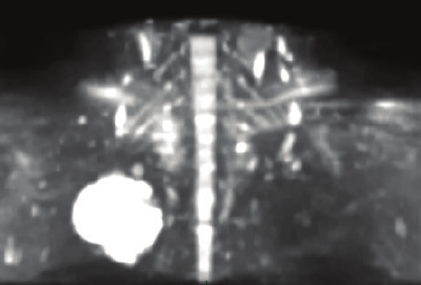
Figure 8: MIP reformatted DW image on the coronal plane which shows the integrity of the brachial plexus. DW imaging makes the radiologist able to selectively identify nervous structures, which have a strong signal intensity and are then clearly visible between the other components of the superior sulcus (which conversely are hypointense). Postprocessing MIP technique allows assessment of the entire brachial